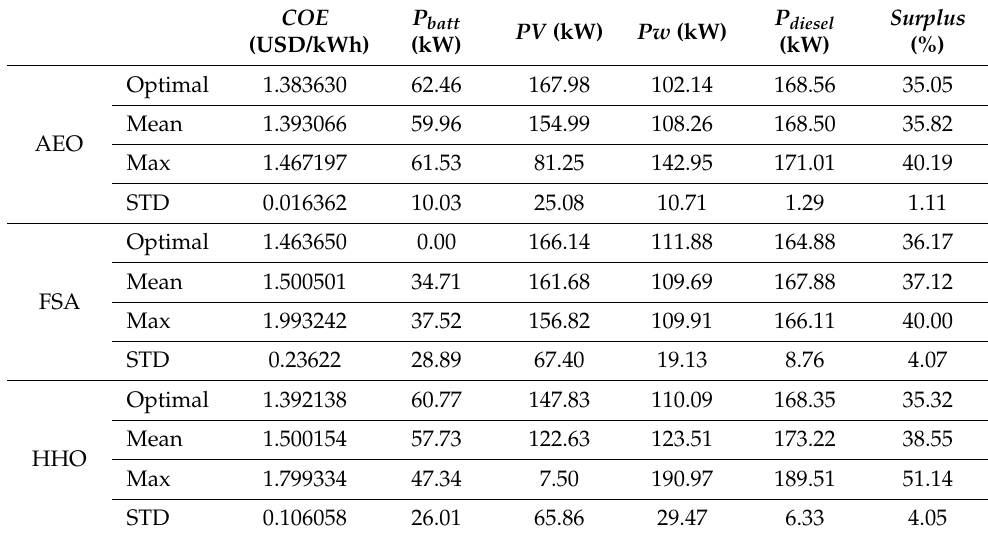
Table 2. Optimal, Minimum, Maximum, and STD for AEO, FSA, and HHO at 40% REF and LPSP of 0%.